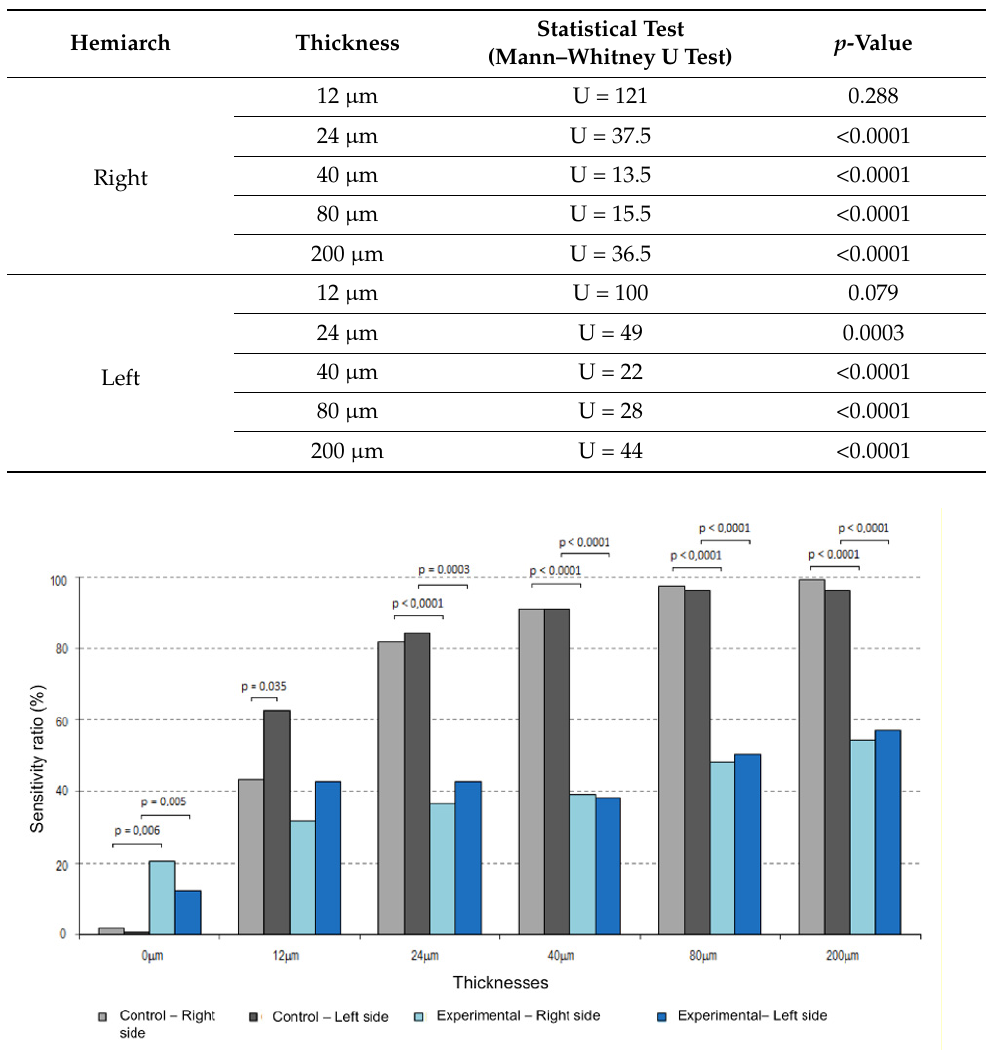
Figure 5. Differences between the groups studied, considering the thicknesses and p -values. Values of p < 0.05 were considered